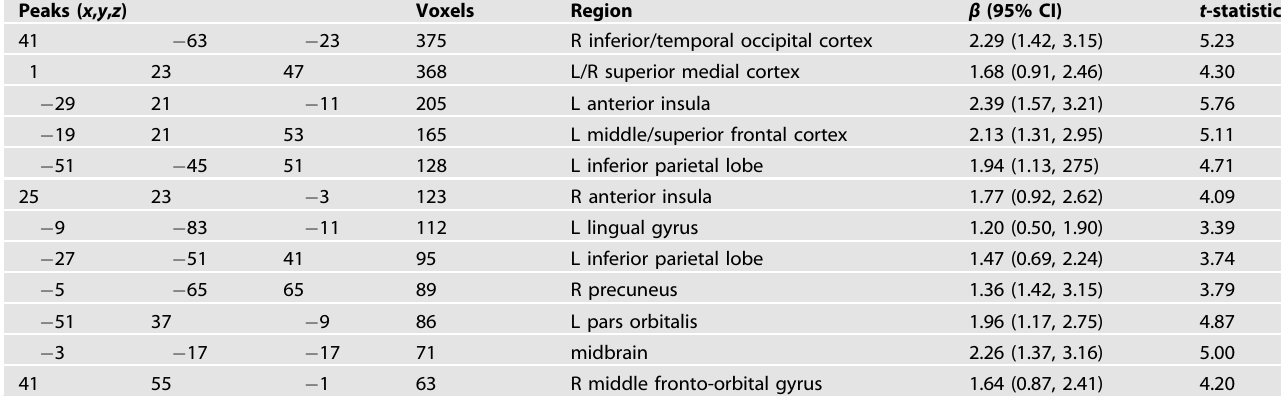
Table 4. Clusters showing the relationship between K d and overall control (Stop vs. Go) in individuals with mood disorders. Peaks ( x , y , z )